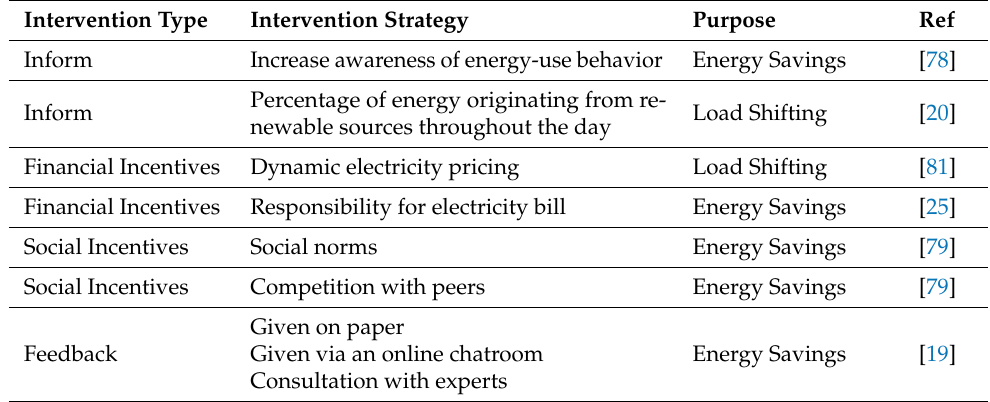
Table 5. An overview of reviewed intervention strategies for encouraging changes in energy-use